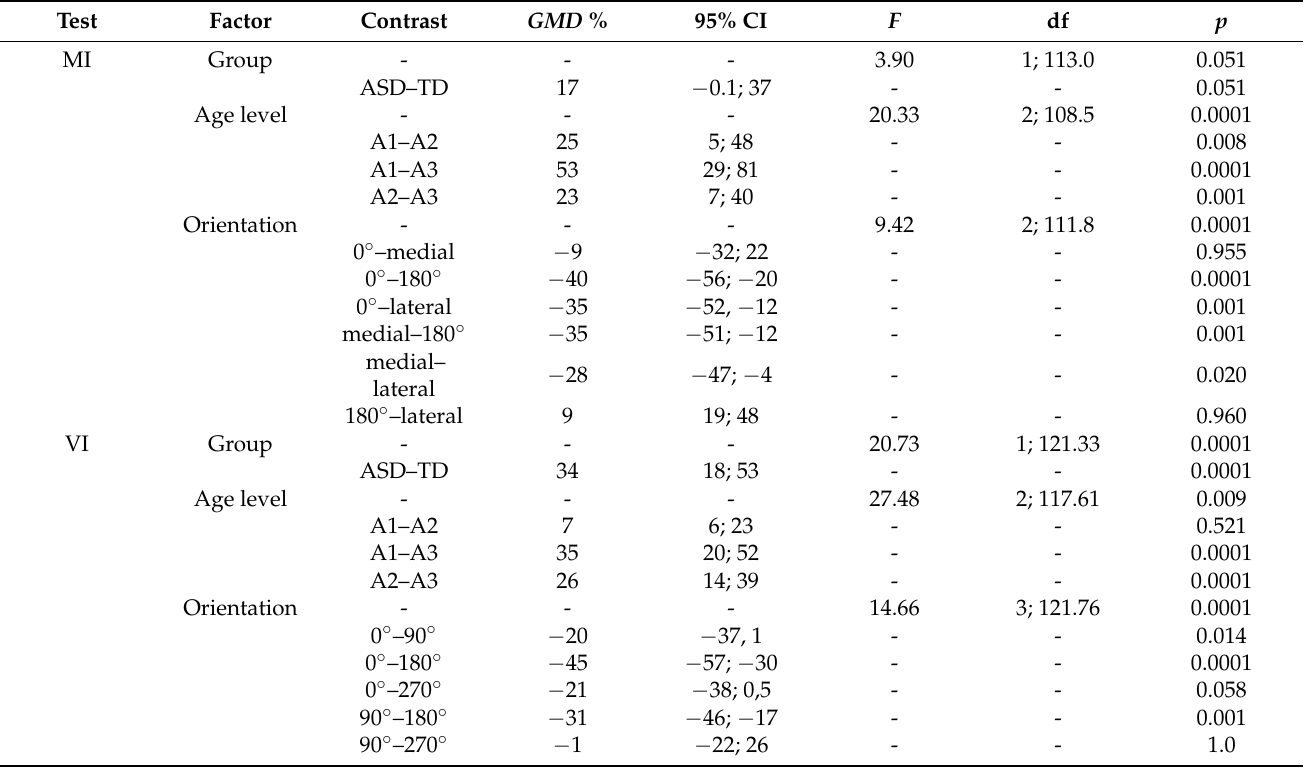
Table 2. Main effects and factorial contrasts organized by test type.